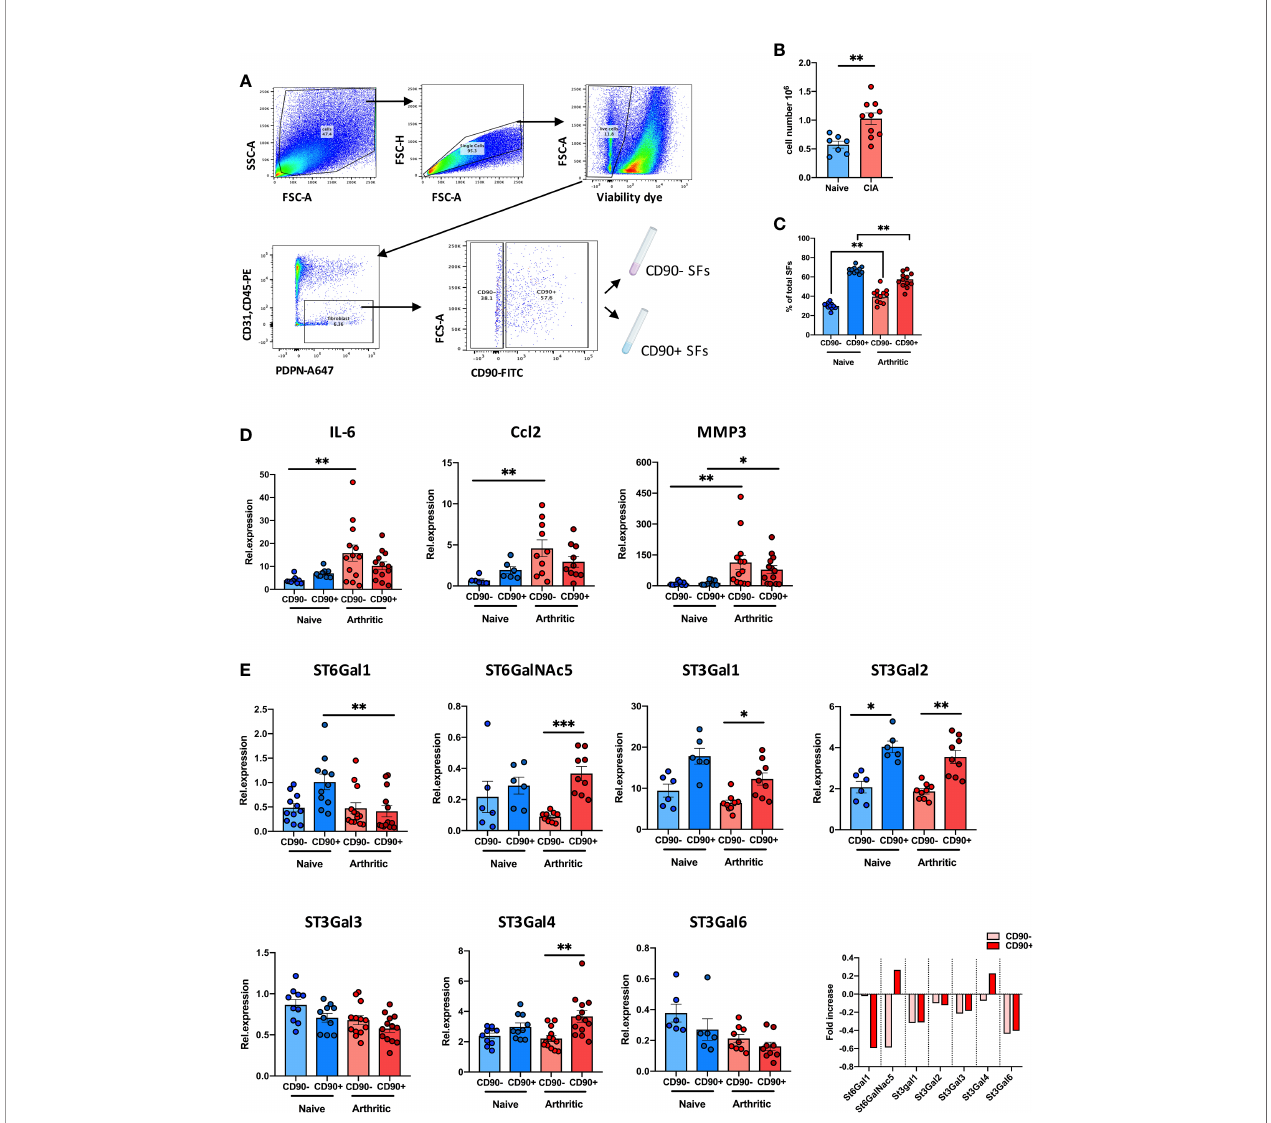
FIGURE 1 | CD90+ SFs show a distinct expression of sialyltransferases in experimental arthritis. (A) SFs were isolated from joints of naïve and mice undergoing Collagen-Induced Arthritis. Cells were sorted by FACs gating on low viability dye, CD31-, CD45- and PDPN+ cells. Subsets of SFs were discriminated by expression of CD90. Sorting strategy is shown in the dot plots. (B) Total number of isolated cells from paws from naïve (n = 7) and CIA (n = 10) animals. (C) Relative proportions of SFs subset (lining: CD90- and sublining: CD90+) in total SFs of naïve (n = 11) and arthritic mice (n = 12) evaluated by fl ow cytometry. (D) Relative expression of IL- 6, CCL2 and MMP3 mRNA in SFs subsets were quanti fi ed by RT-qPCR (n ≥ 6). (E) Relative expression of a 2,3- and a 2,6-sialyltransferases (St6gal1, St6GalNac5, St3gal1, St3gal2, St3gal3, St3gal4 and St3gal6) were quanti fi ed in SFs subsets by RT-PCR (n ≥ 6). Data are represented as mean ± SEM; each dot represents SFs from one individual mouse. **p < 0.01 by Mann-Whitney test in (B, C) , *p < 0.05, **p < 0.01, ***p < 0.001 by Kruskal-Wallis test in (D, E)